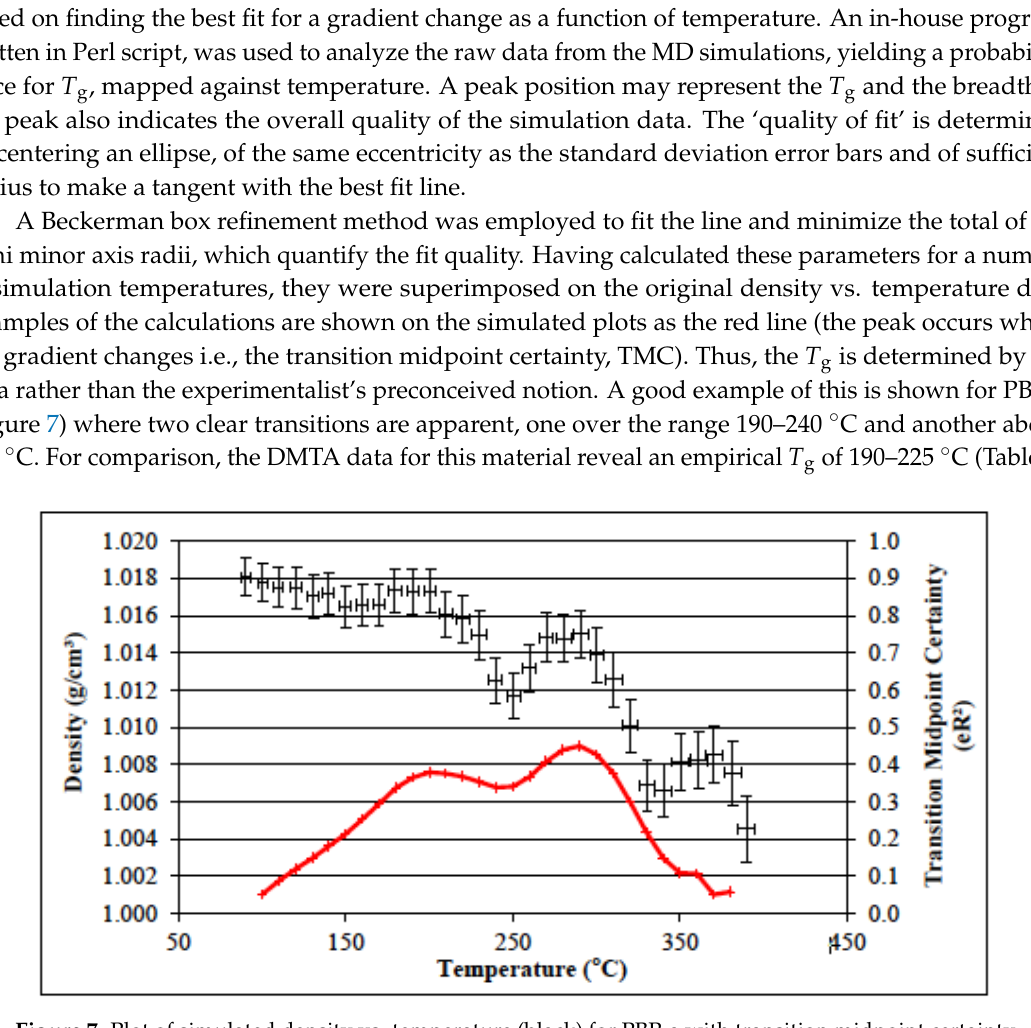
Figure 7. Plot of simulated density vs. temperature (black) for PBP-a with transition midpoint certainty aid (red). Table 6. Comparison of empirical T g values with molecular dynamics